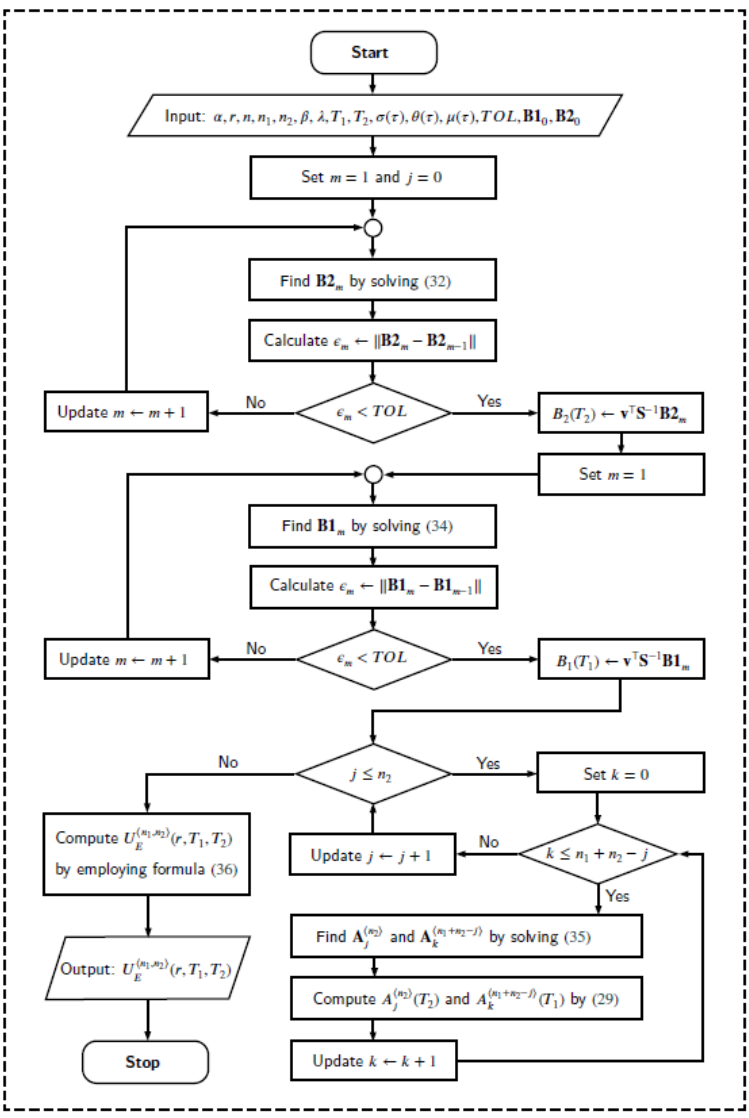
Figure 2. The flowchart for computing numerical formula of Theorem